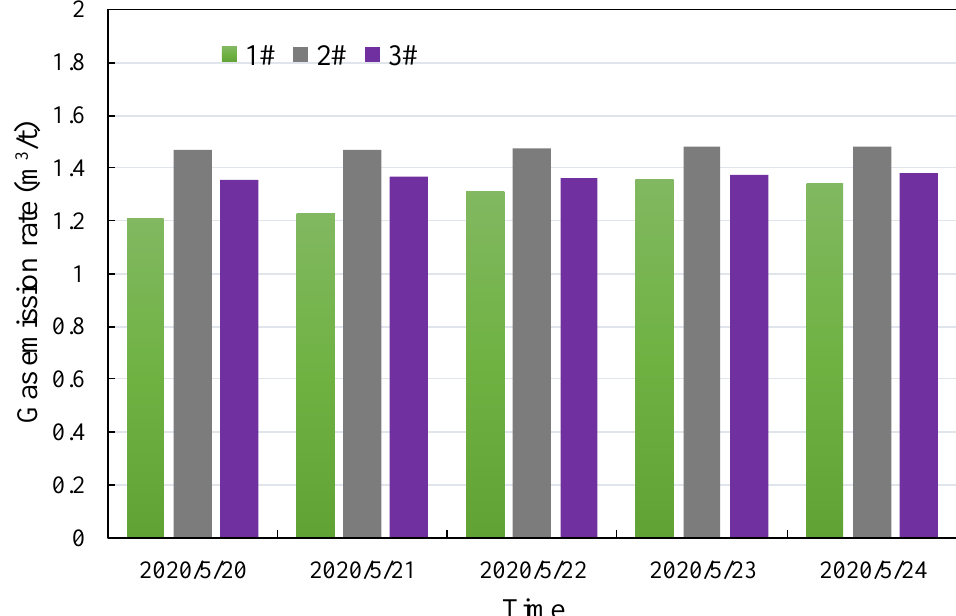
Figure 2. Analysis of measured value of gas emission in working face.